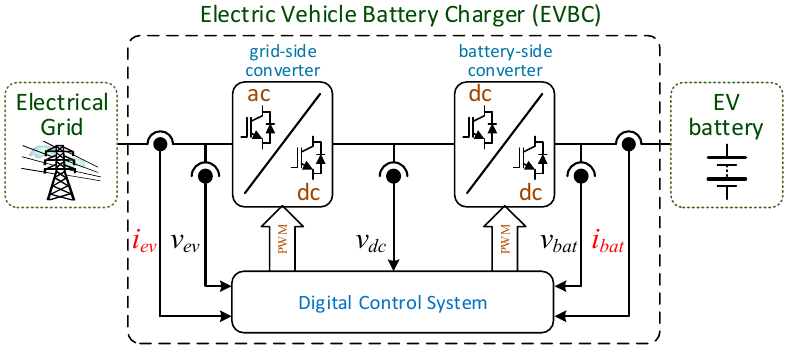
Figure 1. Structure of an electric vehicle battery charger (EVBC) composed of two power converters (a grid-side one interfacing the electrical grid and a battery-side one interfacing the EV battery) and the digital control system.